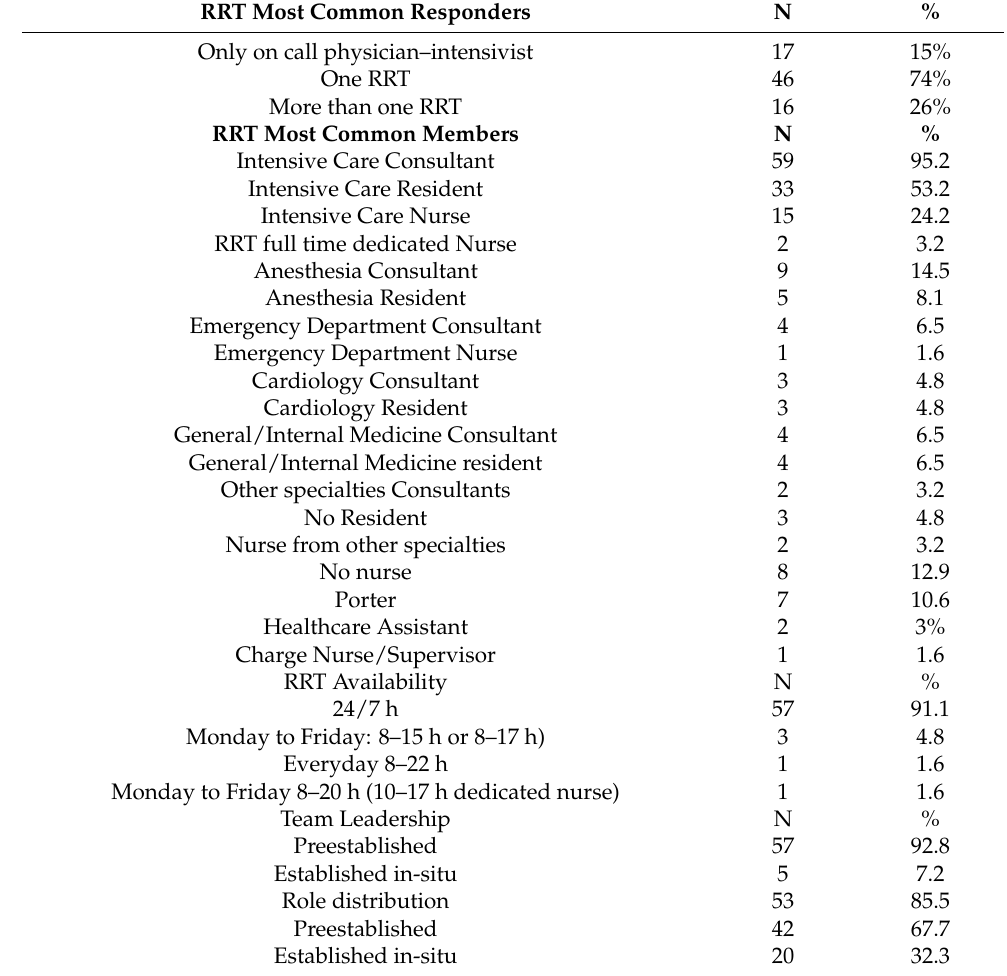
Table 3. Efferent limb: